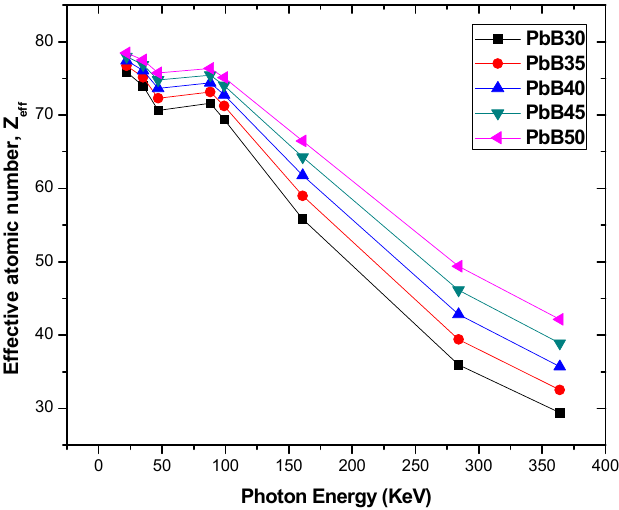
Figure 4. Variation of Z eff with photon energy for PbB30–PbB50 glasses. The thickness of an attenuating medium required to attenuate incident photons by 50% is termed the half value layer/thickness (HVT). It is an easy parameter for stating and analyzing the shielding prowess of any medium. The effect of PbO molar content of the PbB-glasses on the HVL at different energies is depicted in Figure 5. The figure obviously showed that PbO content of the glasses influences their respective HVT at each photon energy. The growth of PbO molar concentration in the glass system decreases the HVT of the glasses at each energy. The reduction of the HVT is due to the high density and effective atomic number of the glasses with higher PbO content as interaction cross section of photon increases with atomic number and particle density. This is an indication that photon attenuation efficiency is directly proportional to the PbO content in the PbB- glasses. Hence, thicker PbB glasses with lower PbO content is required to achieve similar attenuation level compared to one with higher PbO content and vice versa.